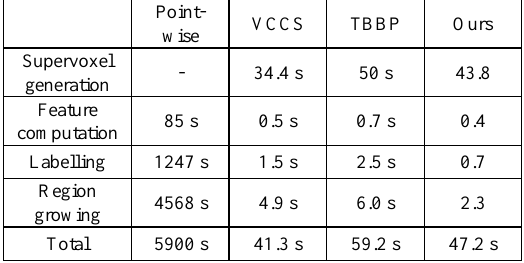
Table 3. Time consumed (in seconds) of different methods with a subset of the TLS test data containing about 5 million